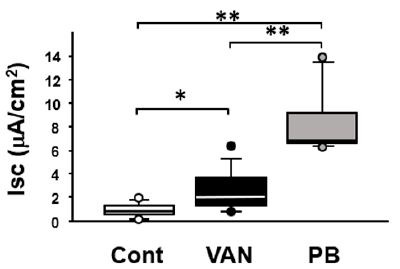
Figure 4. Effect of antibiotic treatment on intestinal permeability in mice. Macromolecular permeability was assessed using the Ussing chamber system. Data are presented as medians and interquartile ranges. Cont, control ( n = 8); VAN, vancomycin ( n = 9); PB, polymyxin B ( n = 6). Significant differences between two groups at * p < 0.05; ** p <